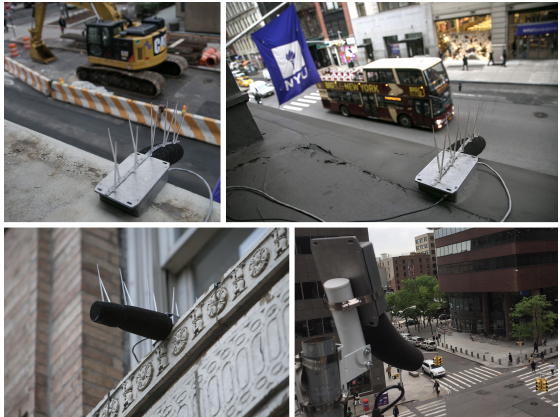
Figure 1. Acoustic sensor nodes deployed on New York City streets.